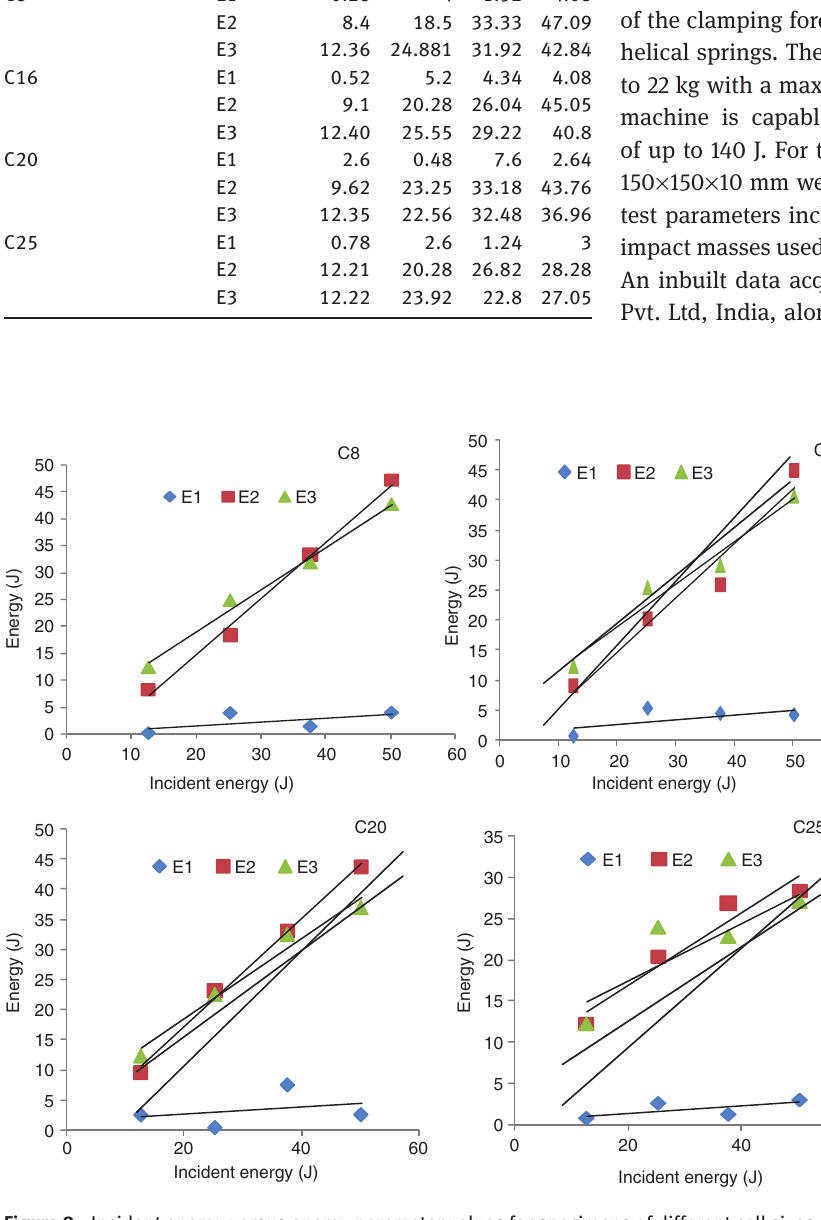
Figure 8 Incident energy versus energy parameter values for specimens of different cell